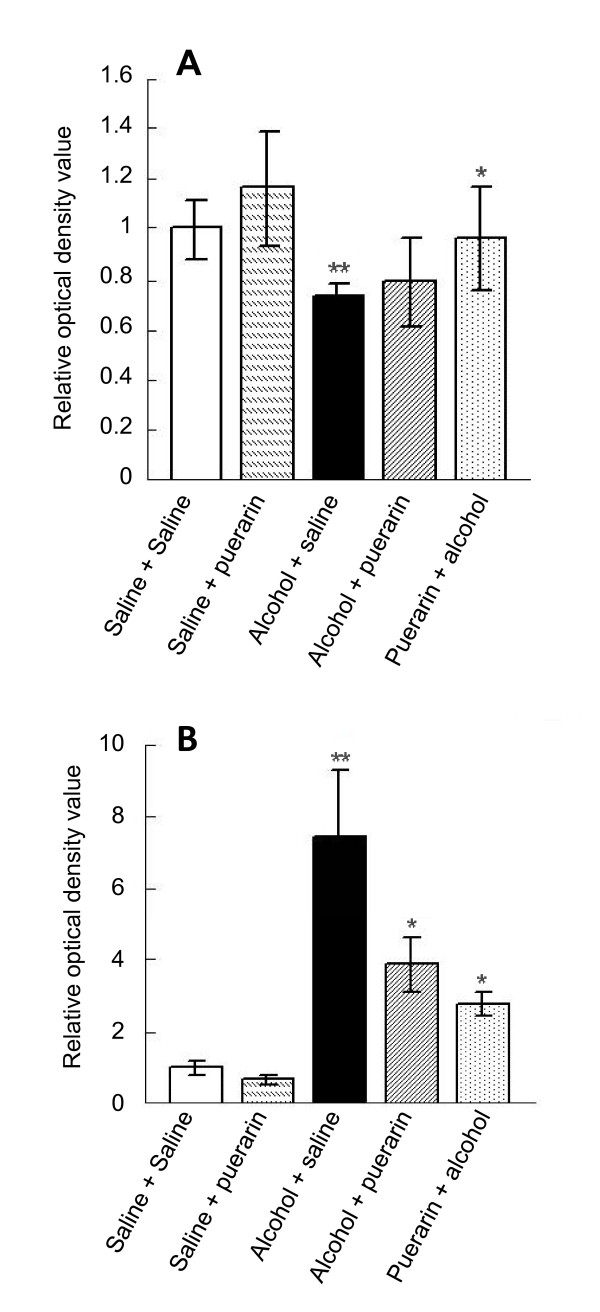
Effects of puerarin on expression changes of GABAAR α1 and α4 subunits in an alcoholic rat model. (A) Changes of expression of GABAARα1; (B) changes of α4 subunit Values are expressed as mean ± SD (n = 3). *P < 0.05 compared with 'alcohol+saline' treated group; **P < 0.01 compared with 'saline+saline' treated group.